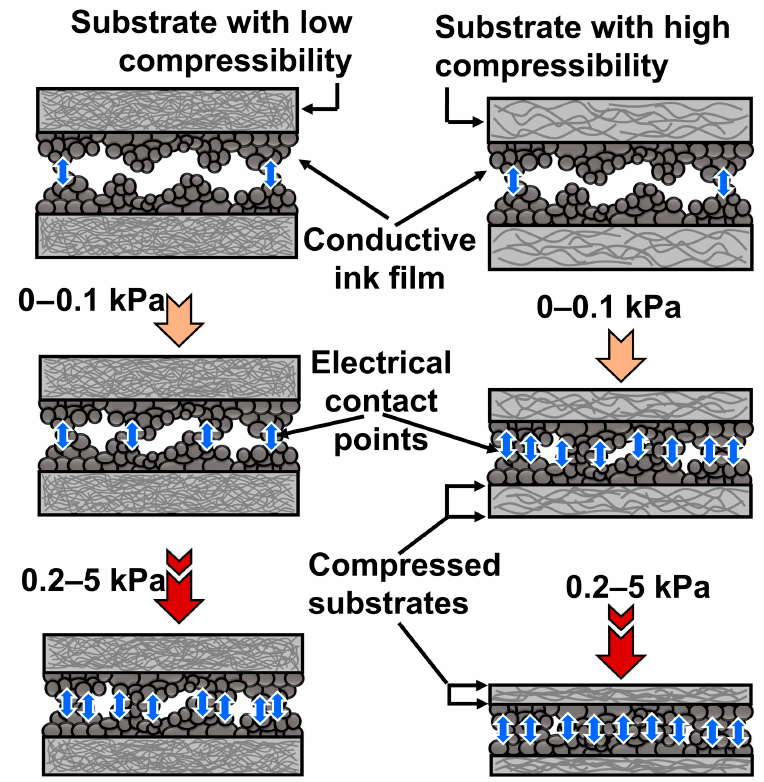
Figure 6. Schematic diagram to show the ECR variation mechanism for our tactile sensors with the substrates in di ff erent porosity/compressibility. The arrow symbolizes the electrical contact points through which electrical conduction occurs. Compression of cellulose fi ber substrates under applied pressure also can be observed in this fi gure. Two di ff erent types of cellulose fi ber substrates, which have low and high poros- ity/compressibility, are shown in Figure 6. The substrates with low porosity and com- pressibility (CS, S1 and S2) generate relatively fewer electrical contact points at the inter- faces compared to the substrates with high porosity and compressibility (S3 and S4). The physical properties of the substrates were con fi rmed by nanoindentation, pycnometry and